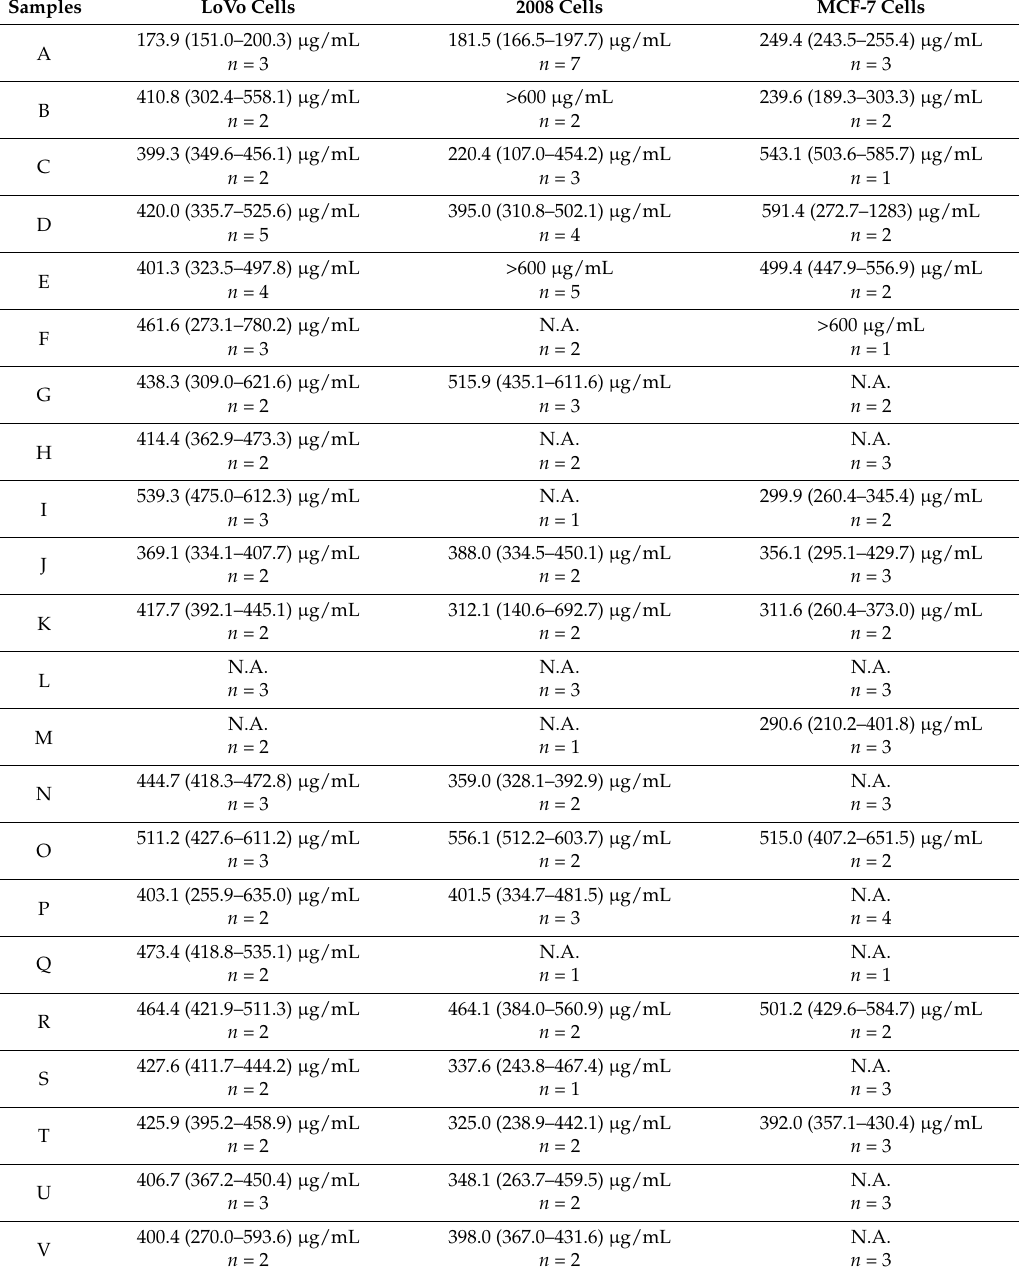
Table 3. Cytotoxic effect of Pistacia essential